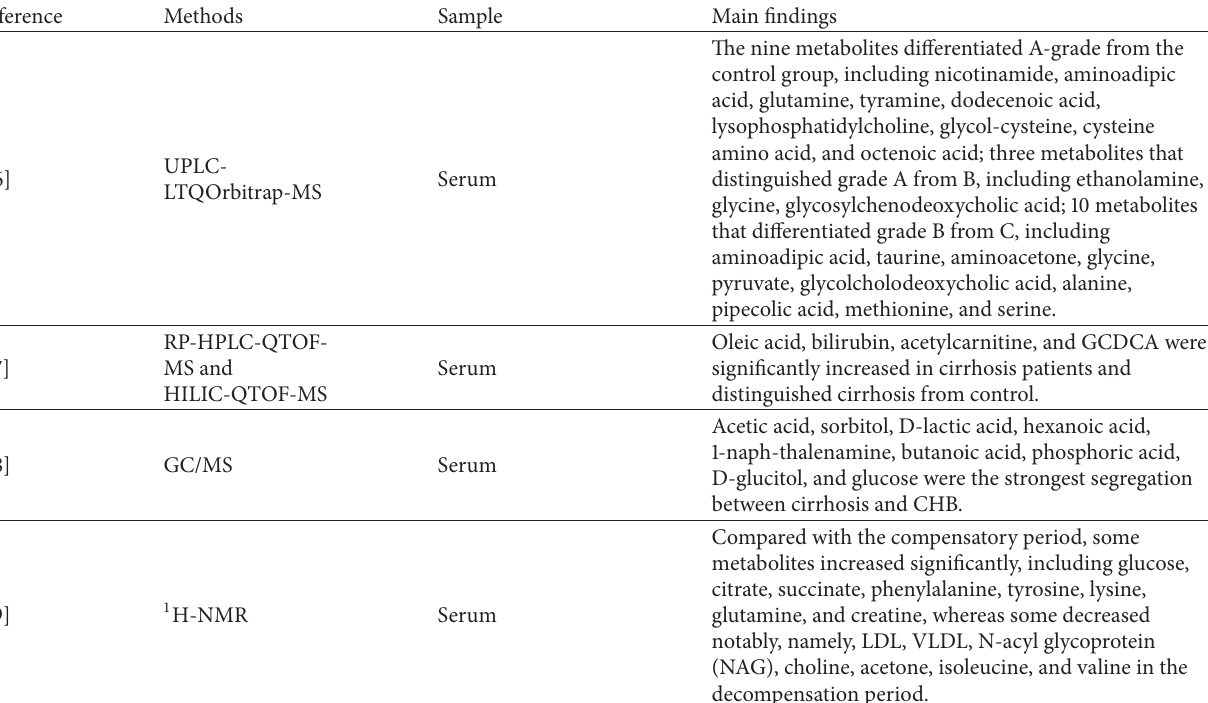
Table 5: The main contents of metabolomic studies on HBV-induced